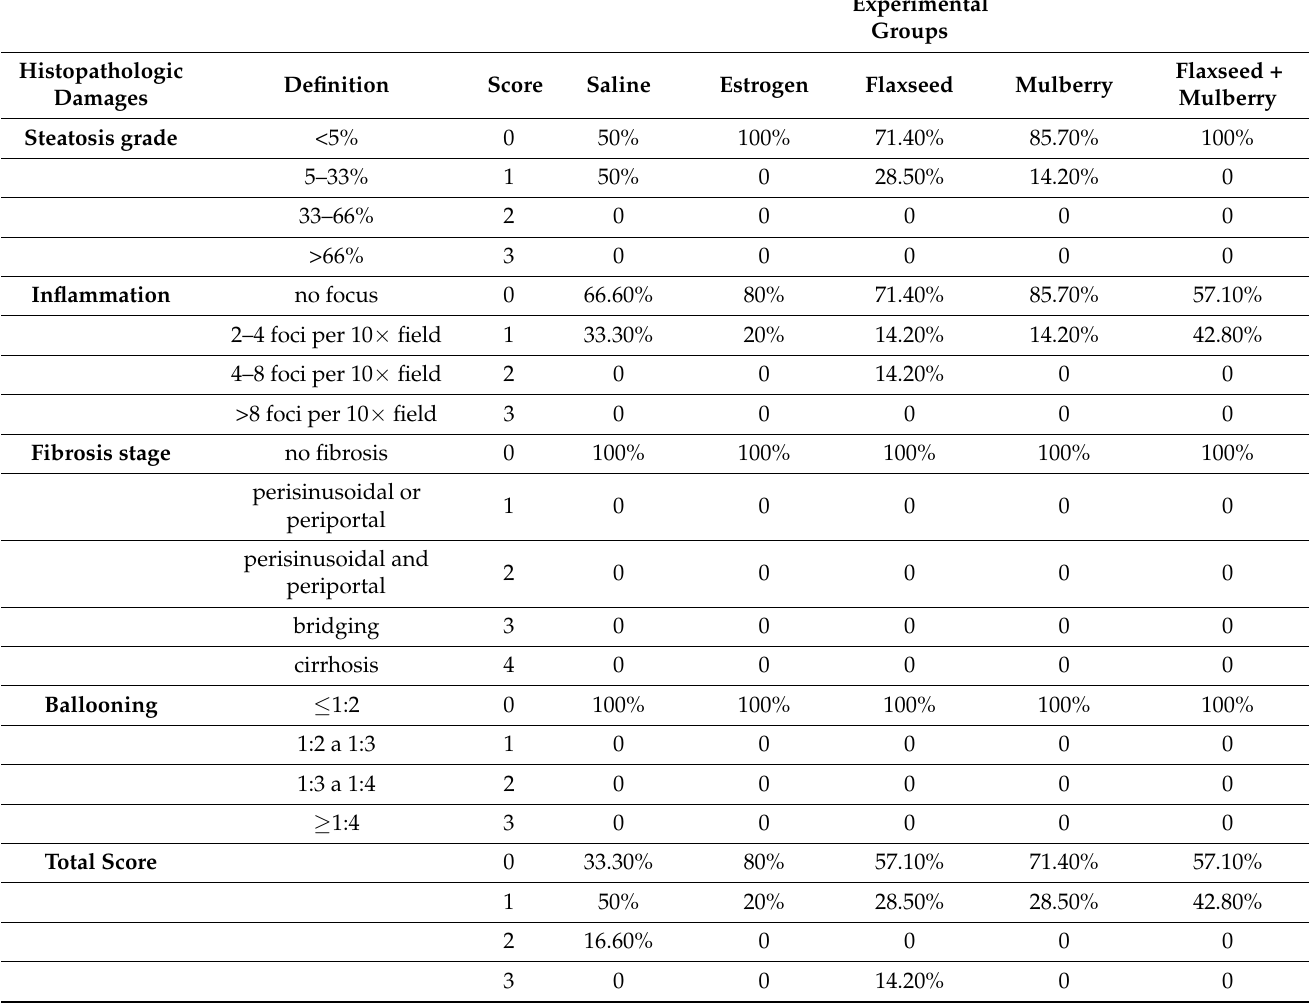
Table 2. Results of the histopathological analyses of the liver of animals treated with saline, estrogen, flaxseed, mulberry, and flaxseed + mulberry extract. Adapted from [1] Kleiner et al. (2005). Steatosis grade: 0 (<5%), 1 (5–33%), 2 (33–66%) and 3 (>66%). Inflammation: 0 (no focus), 1 (2–4 foci